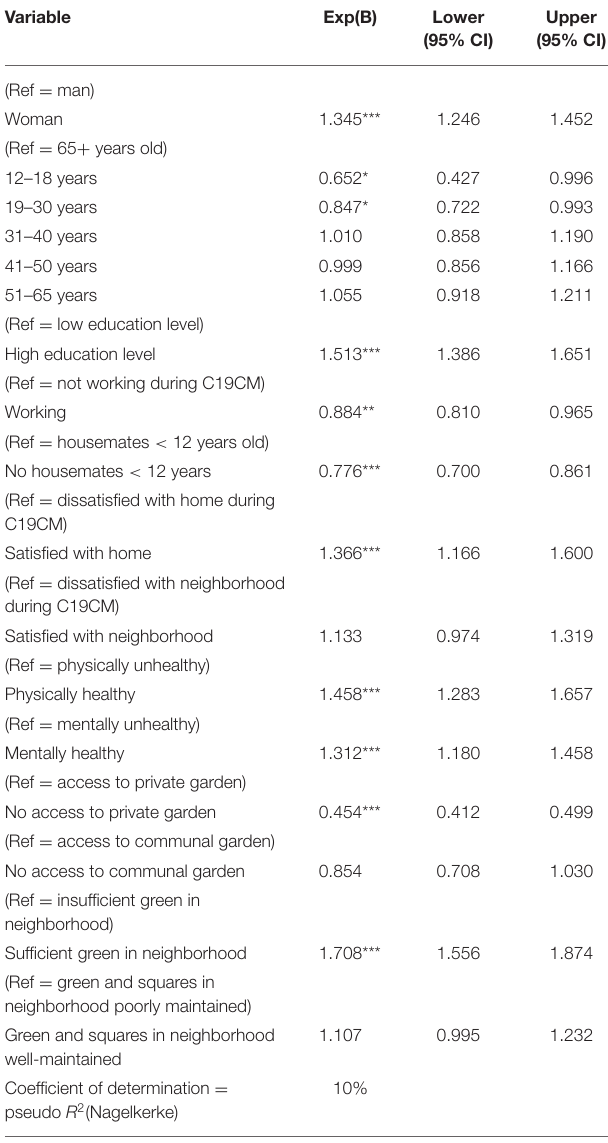
TABLE 2 | Ordinal logistic regression “frequency of nature visit during C19CM” ( N = 10,267; * p < 0.05, ** p < 0.01, *** p < 0.001).